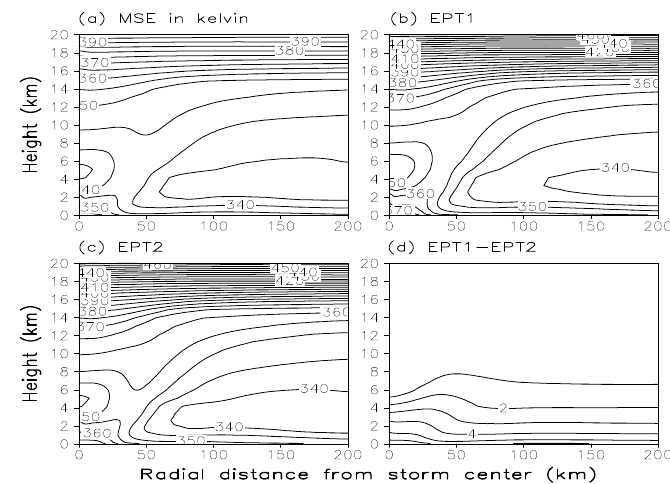
Figure 3. As in Figure 2, but for ( a ) MSE normalized by cp (K), ( b ) equivalent potential temperature (K) defined by Bolton (1980), ( c ) equivalent potential temperature (K) defined by Rotunno and Emanuel (1987), and ( d ) equivalent potential temperature di ff erence (K) between definitions of Bolton (1980) and Rotunno and Emanuel (1987). The panels ( a , b ) incorporate the information in Figure 2 of Ma et al. (2015) [26], but are vertically extended to 20 km since an integration from model bottom to model top ( 20 km) is used in the following budget analysis.